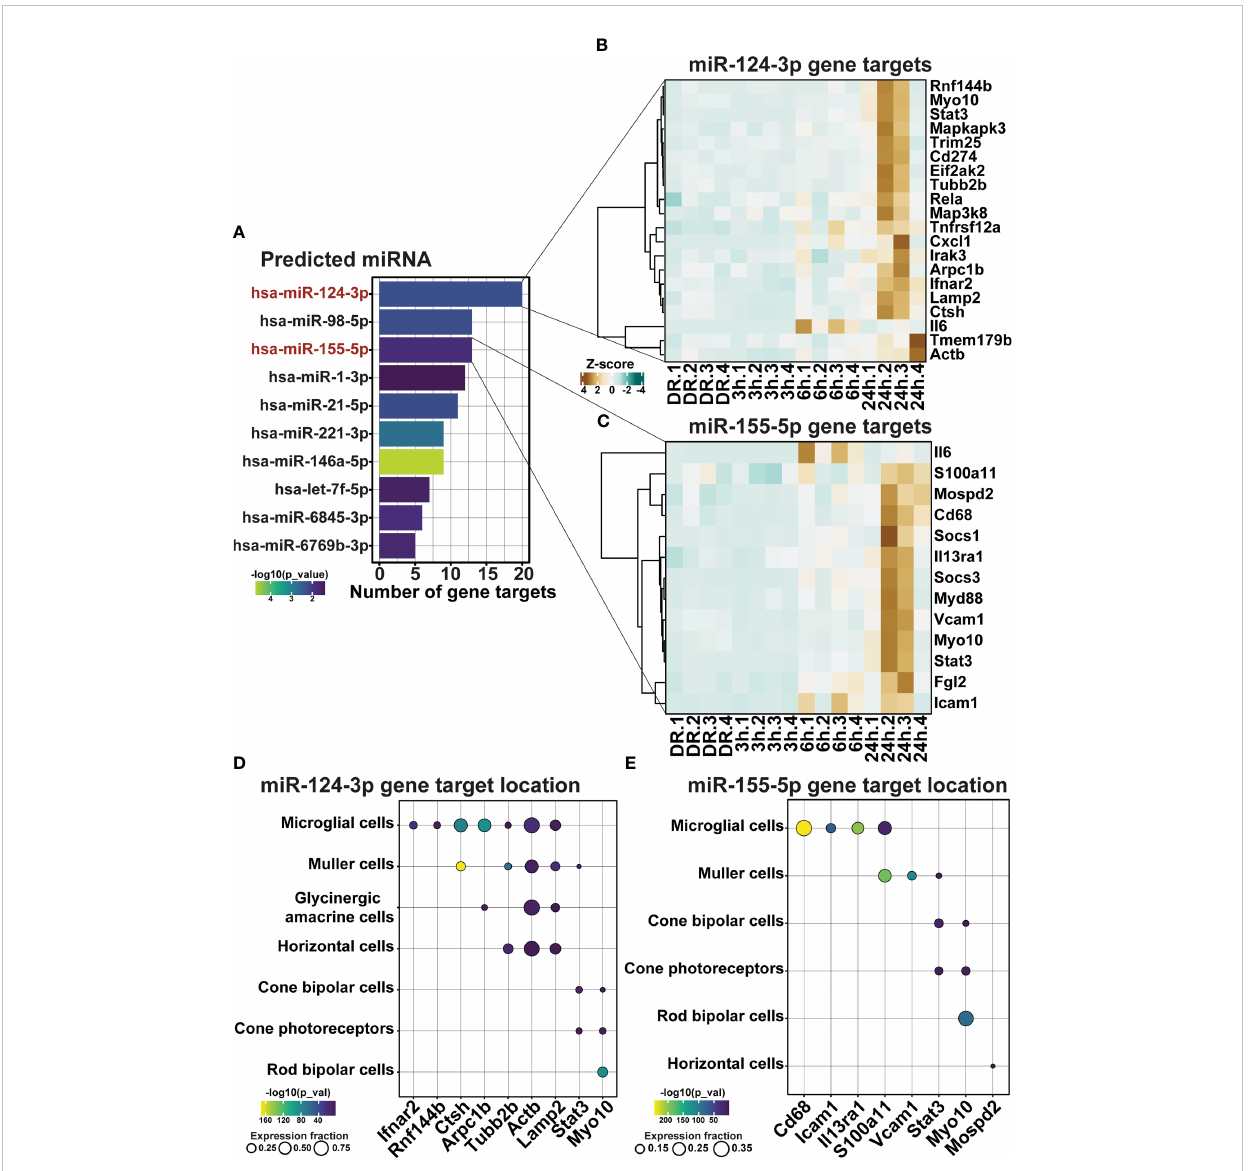
FIGURE 9 miR-155-5p and miR-124-3p associated with the regulation of retinal in fl ammation in early degeneration. (A) Top 10 signi fi cantly predicted miRNA which regulate in fl ammatory genes within clusters 1 and 2. (B, C) Predicted mRNA targets in dim-reared mice within clusters 1 and 2 of miR-124-3p and miR-155-5p . (D, E) miRNA-mRNA target cellular locations in the retina. Signi fi cance determined by p < 0.05, n = 4